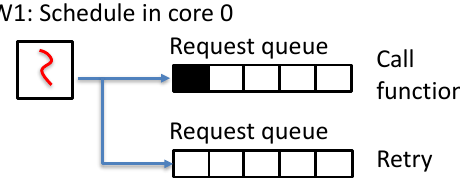
Figure 2. Execution flow of switchless worker threads depending on the queue’s emptiness.